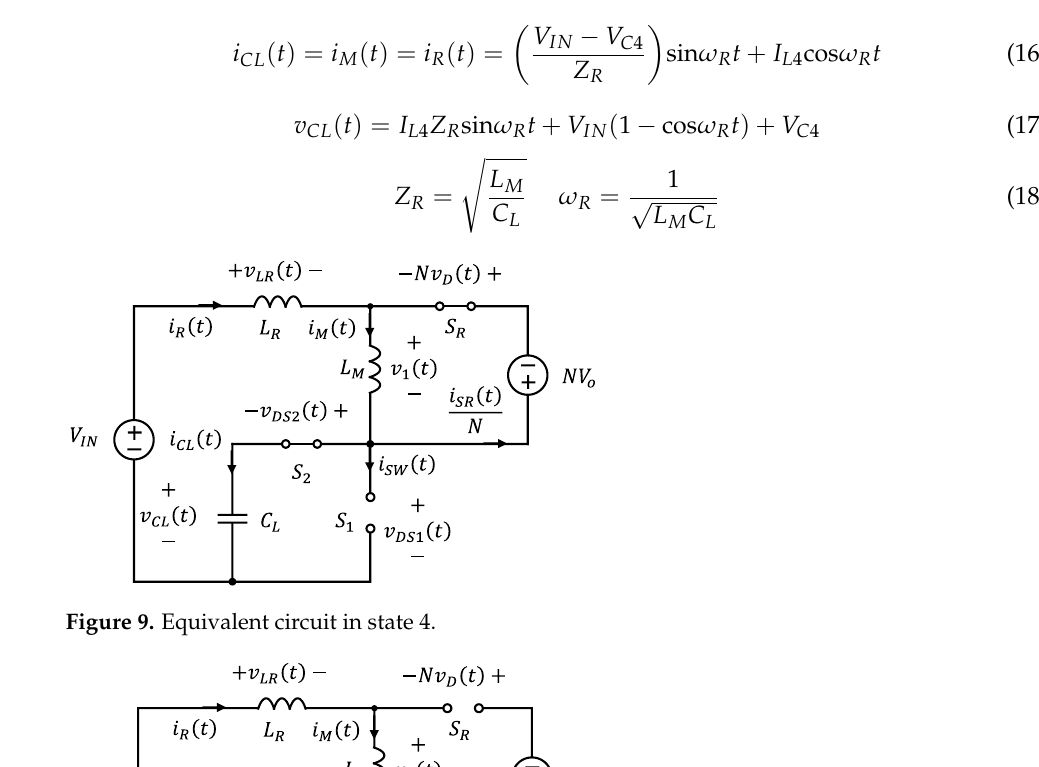
Figure 9. Equivalent circuit in state 4.